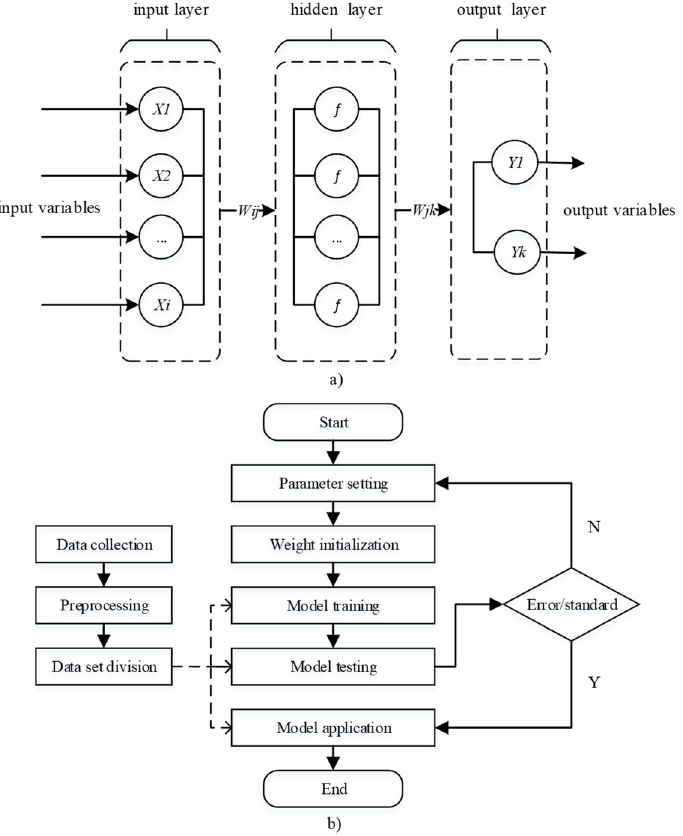
Figure 1. Artificial neural metwork model. ( a ) ANN structure. (Adapted from [24]); ( b ) development process (Adapted from